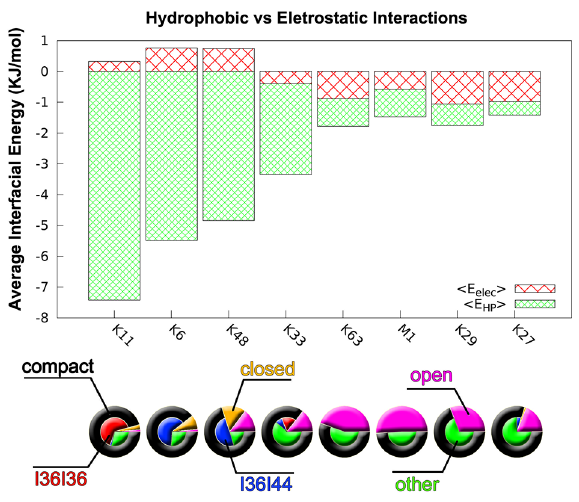
Figure 4. Relationship between conformational populations and interfacial interactions (hydrophobic and electrostatic interactions). The interfacial potential energy is decomposed into hydrophobic energy E hydro and electrostatic energy E elec . The energy distribution of average E hydro and E elec of all eight linkage types is shown. The population distribution of open, closed, compact states is represented by magenta, orange and black pies, respectively. The compact state (black) is further decomposed into the I36I36 (red), I36I44 (blue) and other states (green). See quantitative results in Table 1.